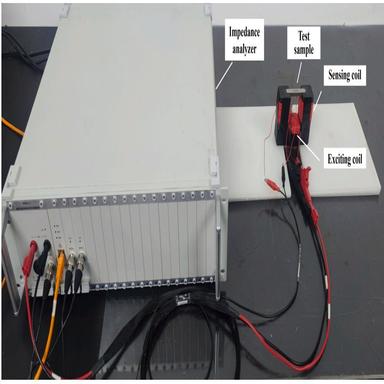
The electromagnetic sensor connecting with the measurement instrument.